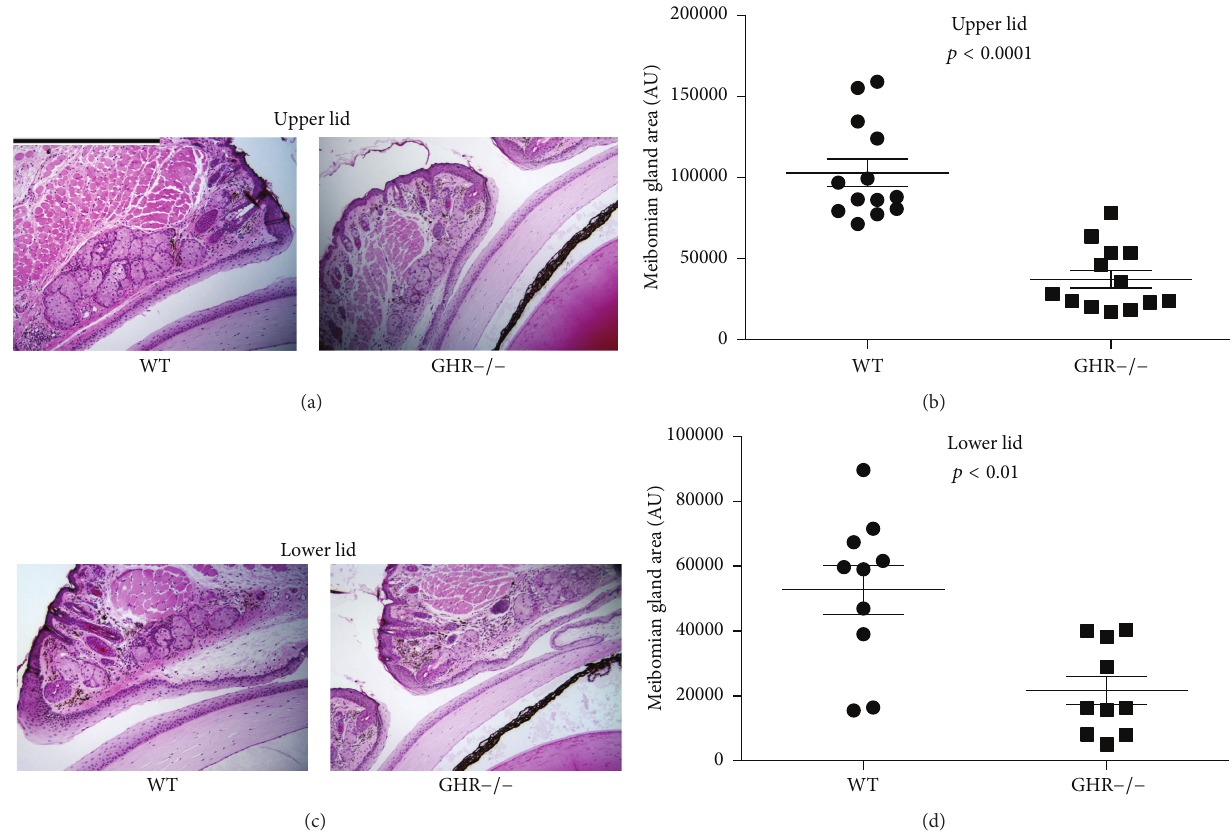
Figure 3: Meibomian gland morphology and size (i.e., area measurement) in male GHR − / − and WT control mice. (a) and (c) H & E staining in the upper and lower lid tissue showing meibomian glands. (b) and (d) quantification of upper and lower lid meibomian gland size. Each data point represents the size of one meibomian gland, the horizontal bar represents the mean, and the error bar represents SEM. Data were pooled from 𝑁 = 3 mice in each group. The magnifications for all photographs are 100x, and the size bar in (a) is 500 𝜇 m in length.